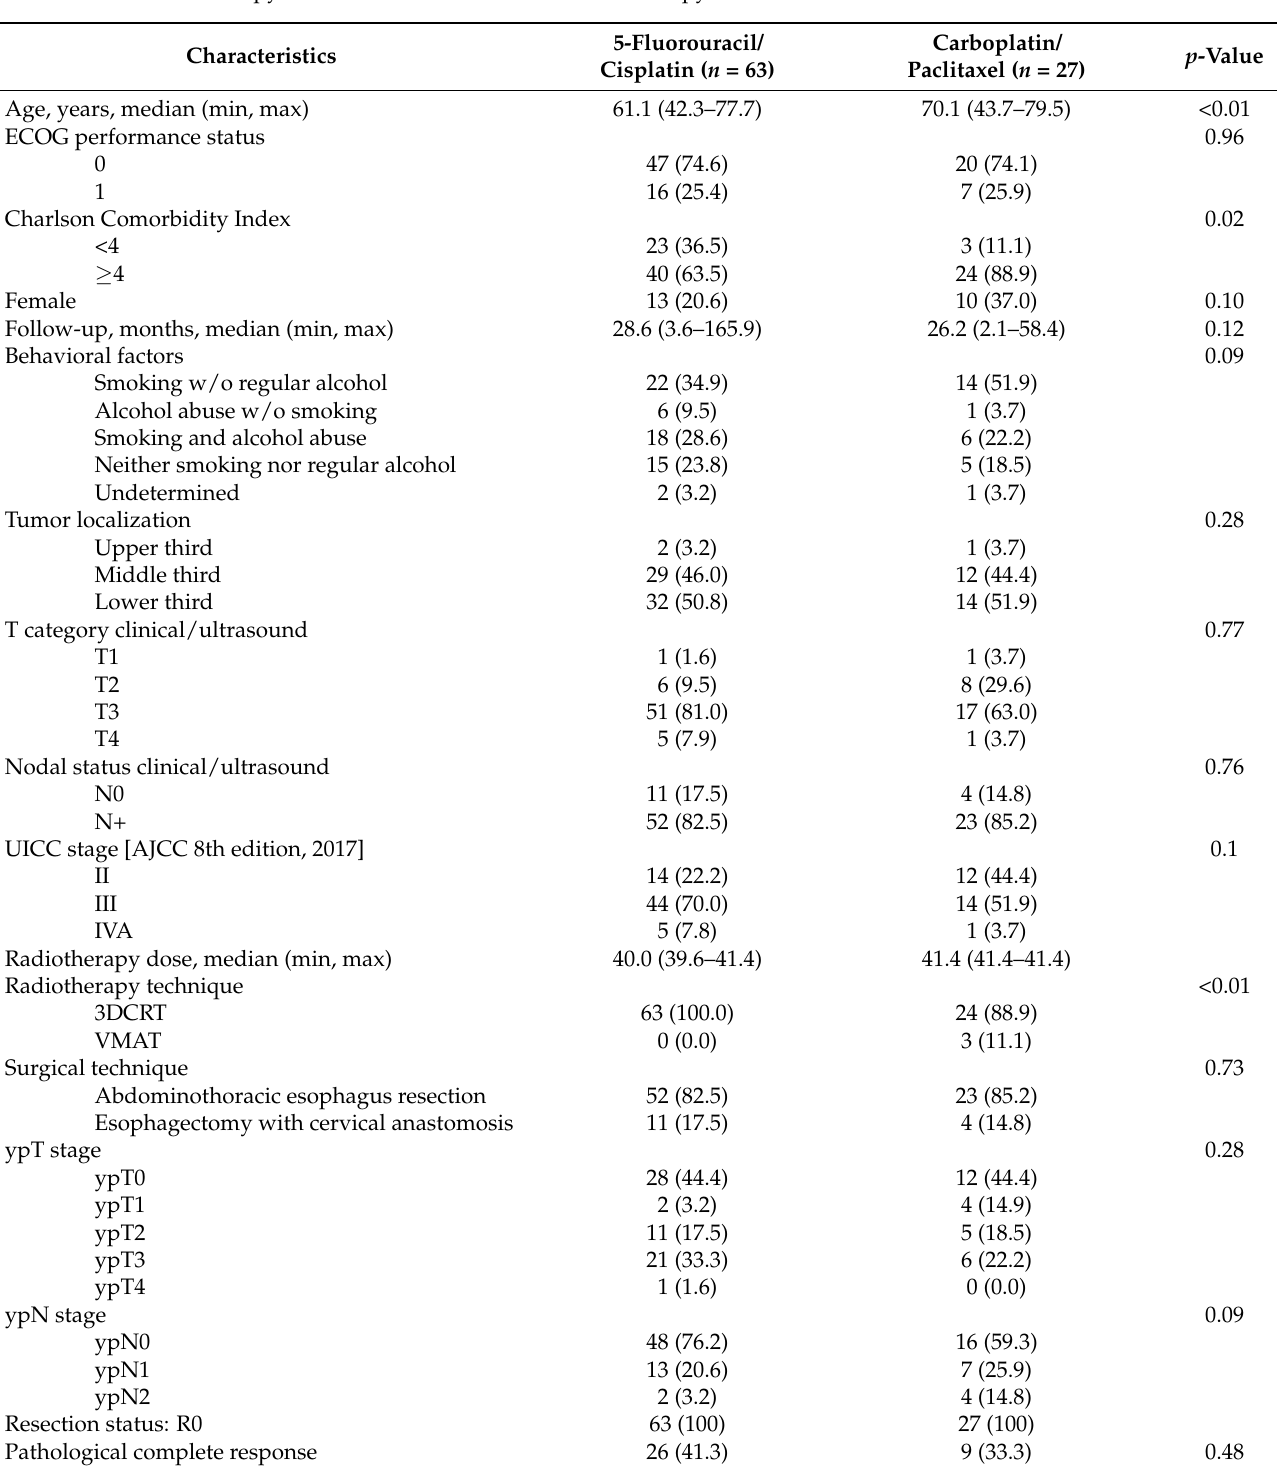
Table 1. Baseline patient and disease characteristics and histopathological characteristics. For each parameter, if not otherwise specified, the number of patients and, in brackets, the percentage are given. The statistical comparisons were performed with Chi-square test and Kruskal–Wallis test. ECOG: Eastern Cooperative Oncology Group. 3DCRT: 3D conformal radiotherapy. VMAT: Volumetric modulated arc